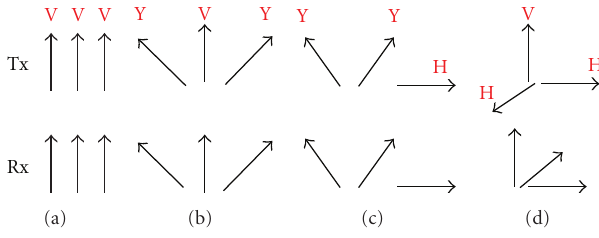
Figure 4: Four antenna configurations which are denoted as (a) VVV, (b) YVY, (c) YYH, and (d) VHH.